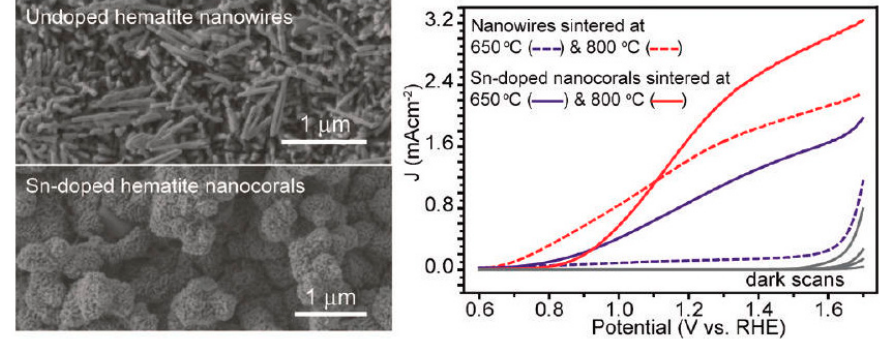
Figure 4. The morphology ( left ) and PEC activity ( right ) of the undoped and Sn-doped hematite photoanodes. Adapted with permission from [46]. Copyright 2012 American Chemical Society.